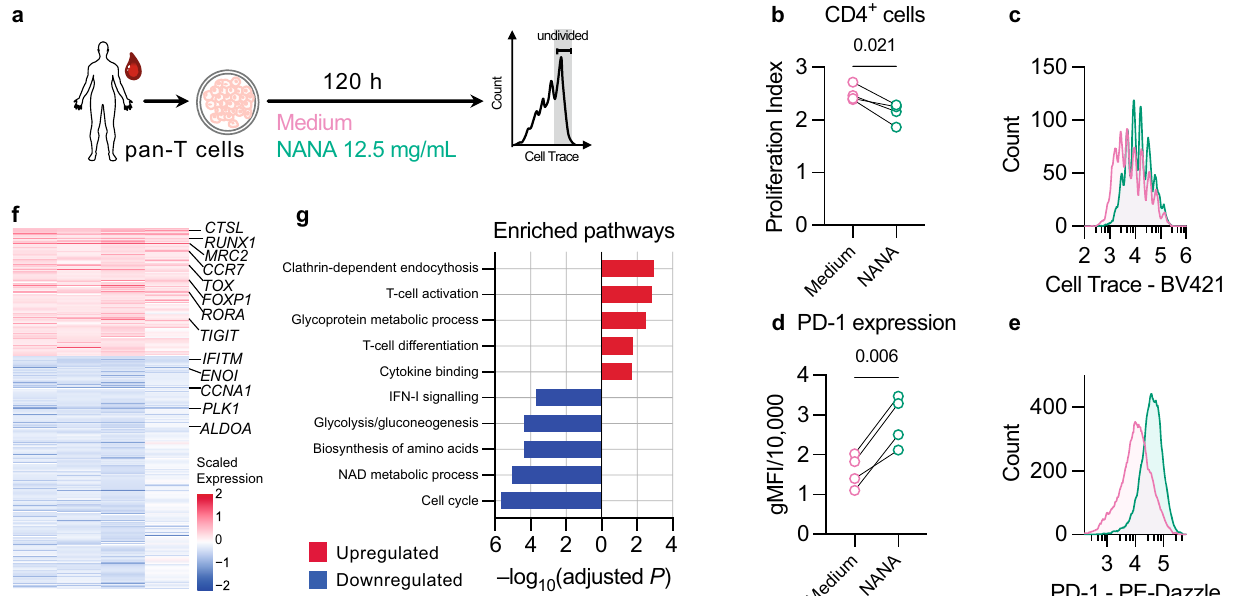
b , d Black lines connect paired points. c , e Histograms of representative samples. f , g Bulk RNA-Seq of the same human T-cell cultures in ( a – e ). f Heatmap showing signi fi cantly (FDR-adjusted DESeq2 P -value <0.050) upregulated (red) and down- regulated genes (blue). Each column represents one individual and each row one gene.Foreachindividual,geneexpressionvaluesareexpressedaslog-transformed fold-changes(NANAversusmediumcontrol). g Barplotshowingsigni fi cantly(FDR- adjusted hypergeometric test P -value <0.050) upregulated (red) and down- regulated (blue) pathways. b – e , g Source data are provided as a Source Data fi